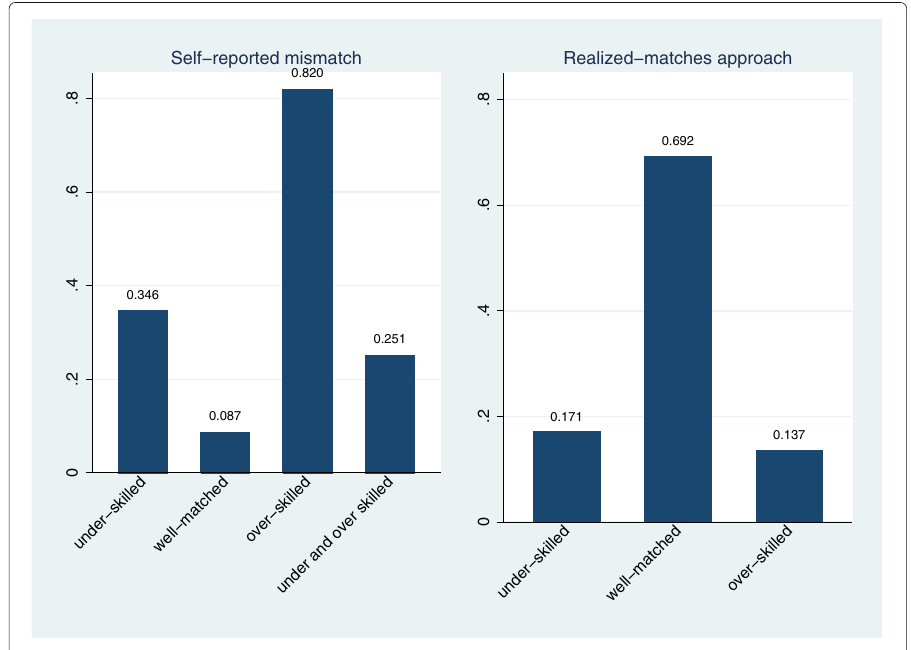
Fig. 6 Comparison with other measures of skill